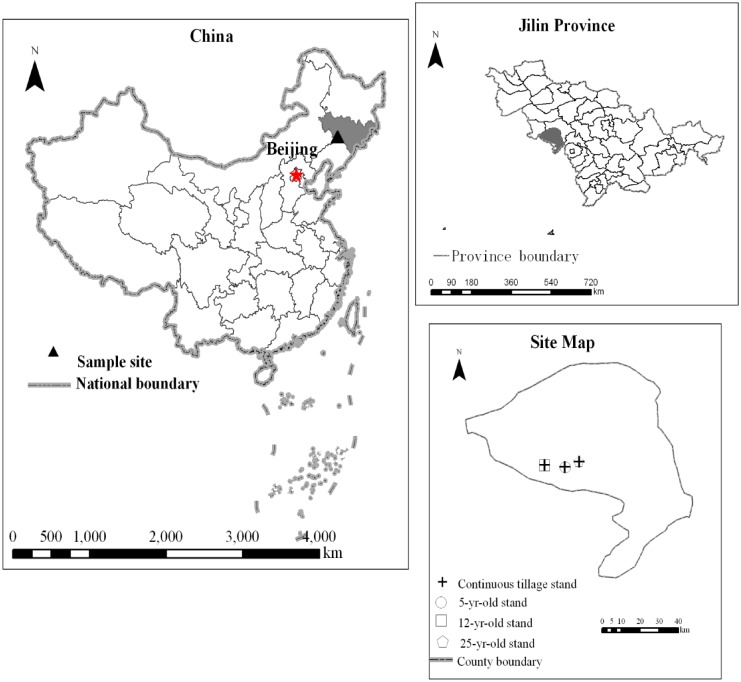
Forest site and adjacent cropland site locations (Jilin province, China).